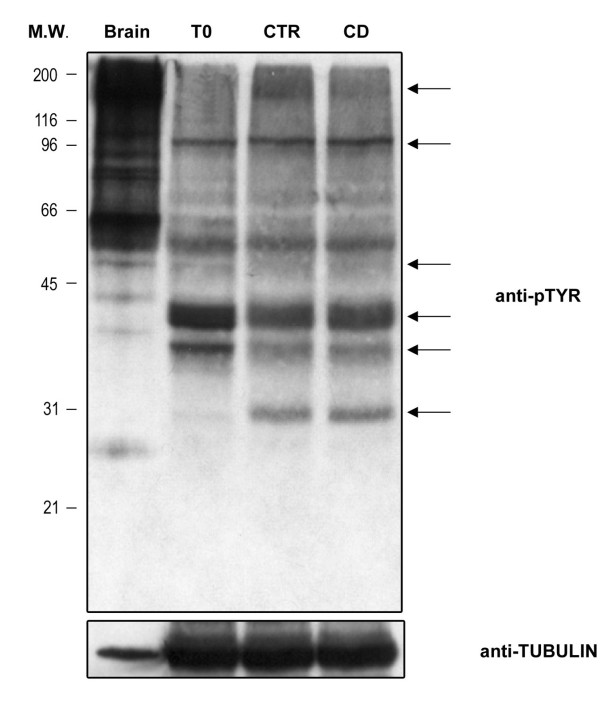
Tyrosine phosphorolation pattern in ejaculated and in capacitated spermatozoa. Western Blot analysis of tyrosine phosphorylation pattern in total lysate of freshly ejaculated male gametes (T0) or in spermatozoa incubated under control condition (CTR) or in the presence of CD (CD). The arrows indicate the capacitation-related changes in P-Tyr. Brain proteins were used as positive control. The filter was normalized on the Tubulin expression. The data shown were representative of three independent experiments.